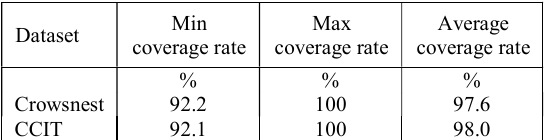
Figure 10. The colour of the dots represents the score of each random point.